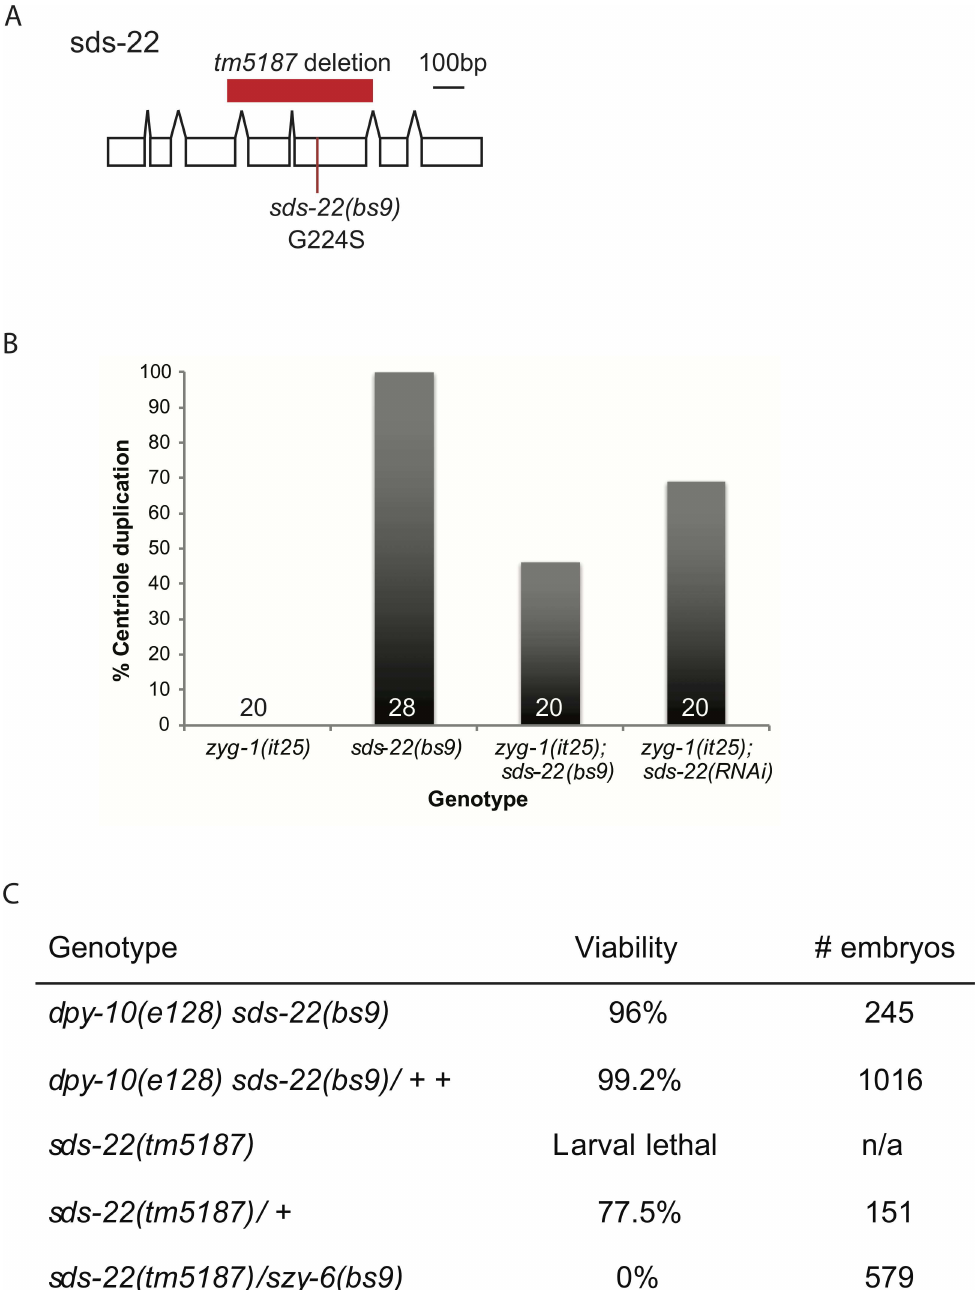
Fig 2. Reducing SDS-22 activity rescuesthe zyg-1(it25) phenotype. A) Scale diagram of the structure of the sds-22 gene, indicatingthe location of the tm5187 deletionand the sds-22(bs9) substitution. B) Quantificationof centrioleduplication when zyg-1(it25) is rescuedby the sds-22(bs9) mutation or sds-22(RNAi) . Number of centrioleduplication events analyzedis indicated. C) Complementation test showing bs9 and tm5187 are allelic. Hermaphrodites of the indicatedgenotypewere shifted to 25˚C at the L4 stage and embryonic lethalitywas determined over the next 24 hours. The szy-6(bs9) allelewas marked with the closely linked dpy-10(e128)